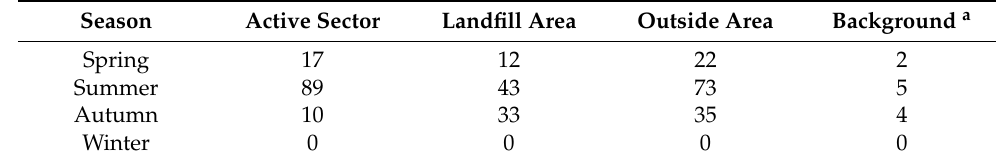
Figure 3. Average abundance (cfu g − 1 dry soil) of Salmonella spp. in the soil samples collected in the seasonal cycle: spring, summer, autumn, and winter. The data presented are means and standard deviation of two replicates. Table 2. Average abundance (cfu g − 1 dry soil) of Salmonella spp. in the soil collected at three groups of research stands during corresponding seasons (spring, summer, autumn, and winter). The active sector includes stand S3; the landfill area includes stands, S1, S2, S4, and S5–S9; outside the landfill area includes stands S10–S17.